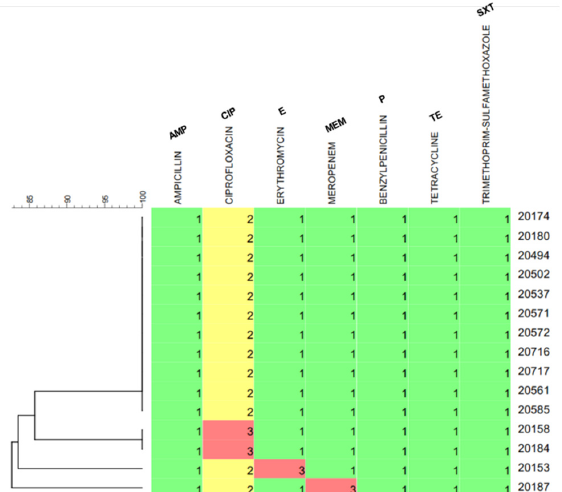
Figure 2. Antibiotic resistance profiles (antibiograms) of L. monocytogenes strains isolated from Myzithra soft whey cheese and related food processing surfaces. The number and color in the antibiogram for each strain designate its resistance to the selected antibiotic: (1) Green: Sensitive strain. (2) Yellow: Intermediate resistant strain. (3) Red: Resistant strain. The first eleven strains are a subsample from the microorganisms’ pool which displayed exactly the same antibiogram profile for better resolution of the